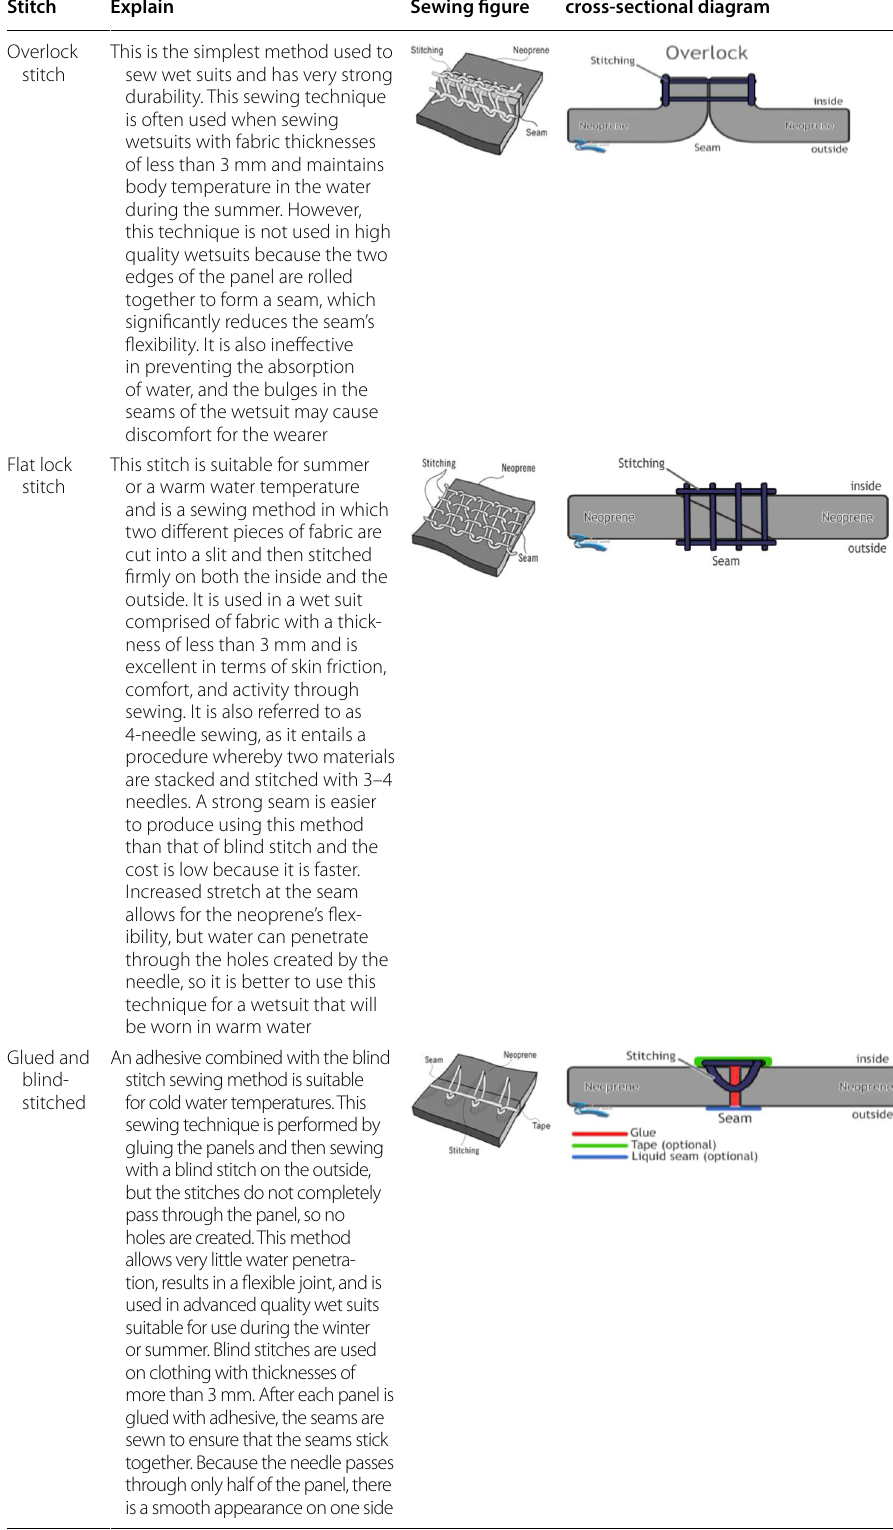
Table 1 General sewing method for wetsuits (Wetsuit Buying Guide 2018) Stitch Explain Sewing figure cross-sectional diagram Overlock